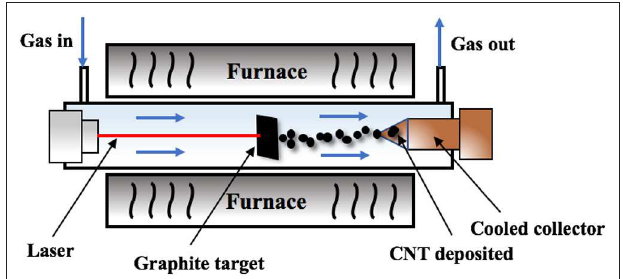
FIGURE 2 | Schematic diagram of CNT formation progress by laser ablation